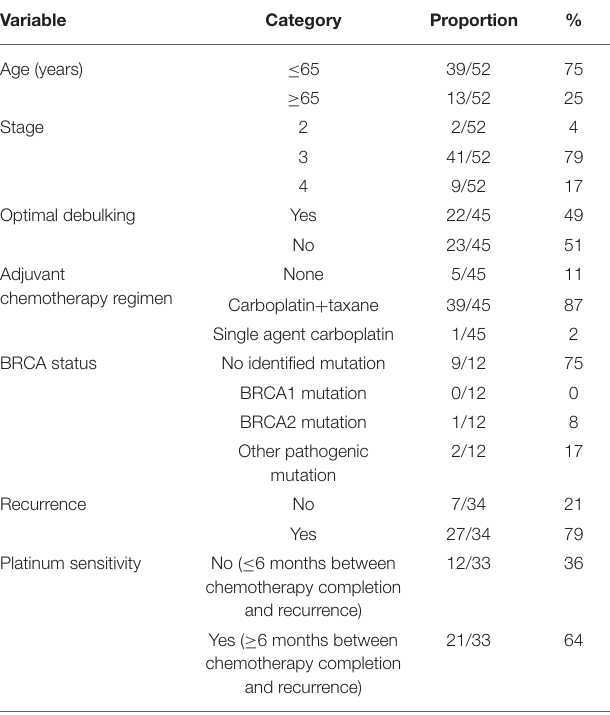
TABLE 1 | Clinical characteristics of HGSOC primary tumor